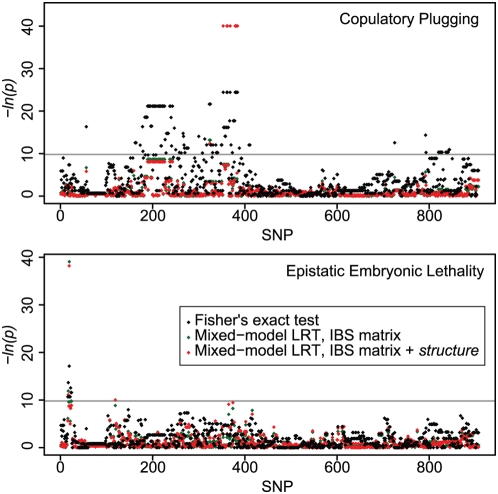
Association mapping in wild C. elegans.Negative log p-values for each of 907 SNPs are shown for two traits and three tests of association. SNPs are ordered by physical position from chromosome I through X. Gray lines represent Bonferonni-corrected p = 0.05 significance thresholds. In the upper plot, the highly significant red points cover identically positioned green points, and these points are plotted at an arbitrary −ln(p) of 40 because the perfect genotype-phenotype association yields an infinite −ln(p) under the mixed-model LRTs. The key applies to both panels.